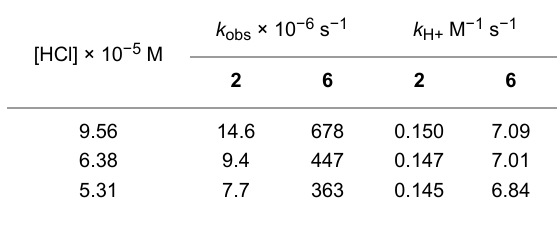
Table 1: Values of k obs and k H+ for 2 and 6 at different acid concentra- tions.